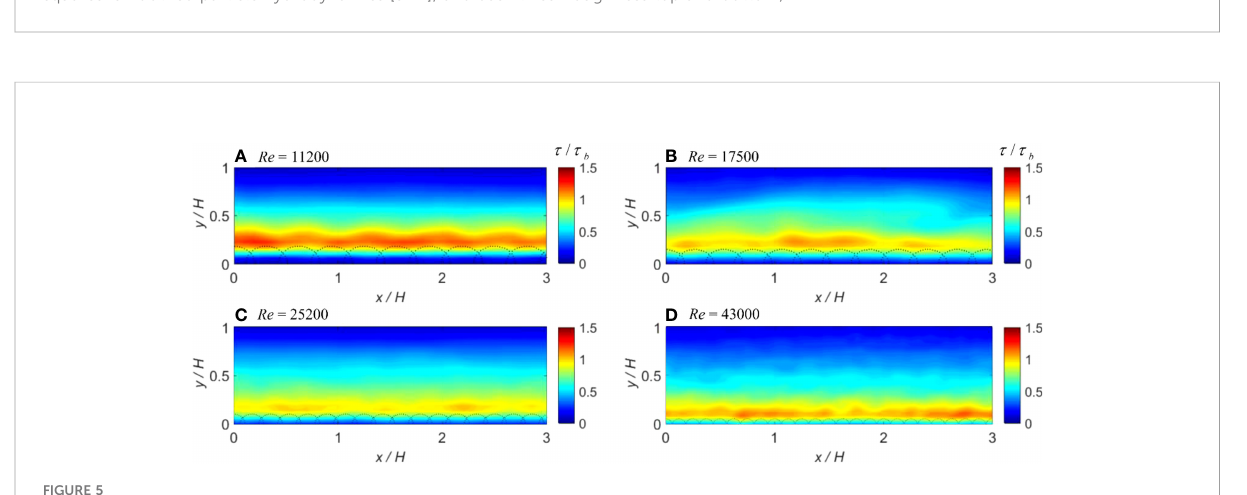
FIGURE 5 (A – D) Longitudinal contours of computed time-averaged shear stresses at the fl ume centerline for different fl ow conditions. The dashed semicircles at the bottom of each panel represent the rough bed spheres.